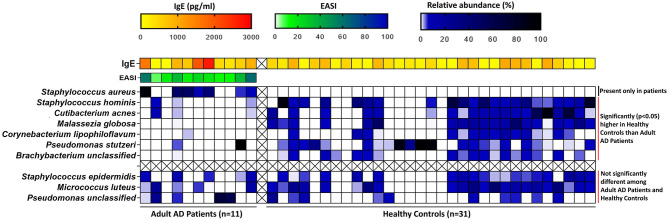
Heatmap of the relative abundances of core microbial species in adult AD patients and healthy controls along with other clinical factors like IgE (for both AD patients and controls) and disease severity index EASI (for AD patients only). The relative abundances of the core microbial species and serum IgE levels were compared between adult AD patients and Healthy controls by non-parametric Wilcoxon rank sum test. The blue-black gradient color band indicates the microbiome relative abundance (%). Staphylococcus aureus was absent in healthy controls. Staphylococcus hominis, Cutibacterium acnes, Malassezia globosa, Corynebacterium lipophiloflavum, Pseudomonas stutzeri, and Brachybacterium unclassified were found to be significantly higher in healthy controls compared to adult patients. The yellow-red gradient color band indicates the IgE concentration (pg/ml). IgE levels were significantly (p = 0.03) higher in adult patients compared to healthy controls. The green-blue color band indicates the EASI (Eczema Area and Severity Index) score. The distribution of EASI scores among adult patients are shown here.